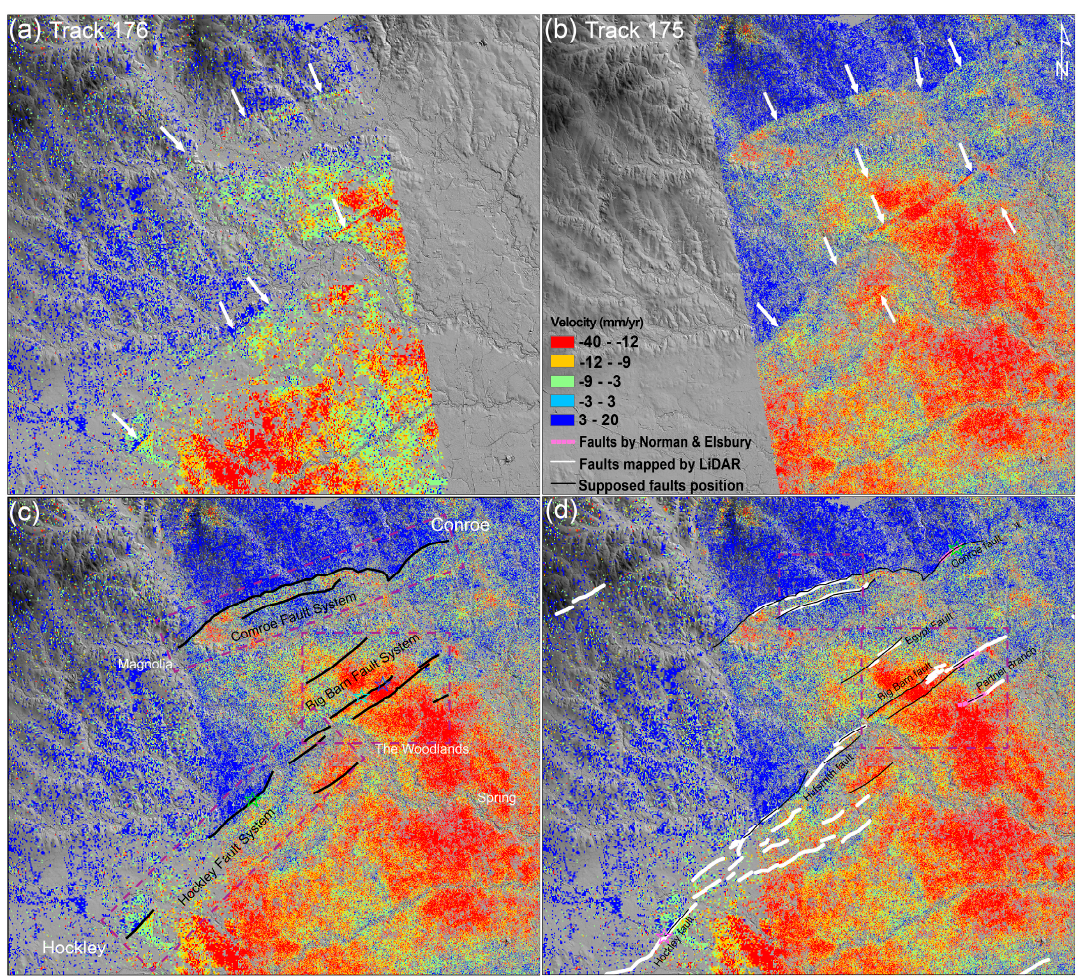
Figure 5. Enlarged deformation maps over northwestern Houston, whose location is outlined by pink dashed rectangles in Figure 3, from two adjacent ALOS-1 paths: ( a ) Path 176; ( b ) Path 175; ( c , d ) Both Path 175 and Path 176. The white arrows in ( a ) and ( b ) represent zones of high deformation velocity gradient (differential movement). White lines represent the faults mapped by LiDAR [10] and pink dashed lines show the faults published by Norman and Elsbury (1991), while newly revealed fractures by our Multi-temporal InSAR (MTI) processing are in black lines. The purple boxes in ( c ) indicate the three discovered faults systems, while the middle one (the same as the bottom purple box in ( d )) is also used for InSAR results validation in Figure 6b. The top purple box in ( d ) shows an area that will be used for fault activity model analysis in Section 5. The colored stars in ( c ) and ( d ) mark positions for field survey and validation in Figure 6a,c–g.